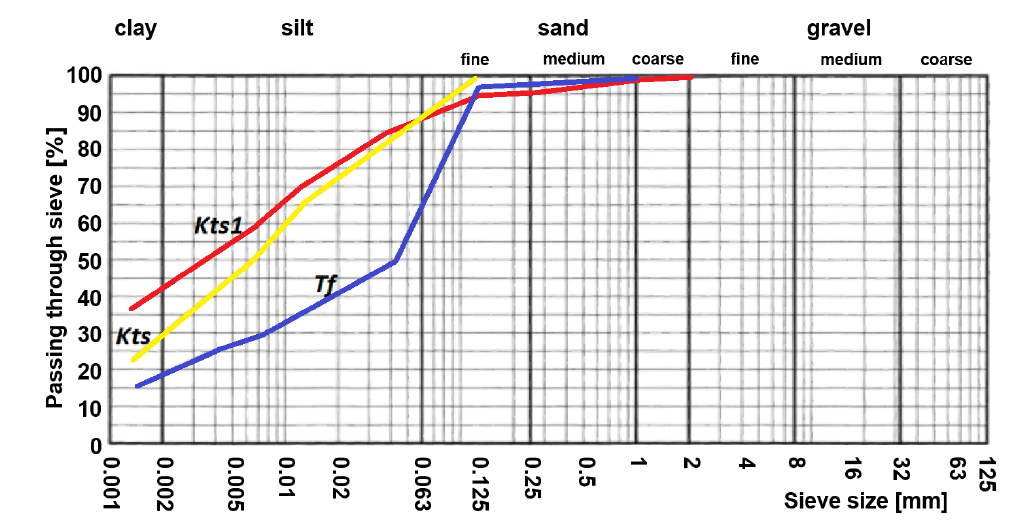
Figure 3. Grading curves of the three main IG types of soils, after [4]